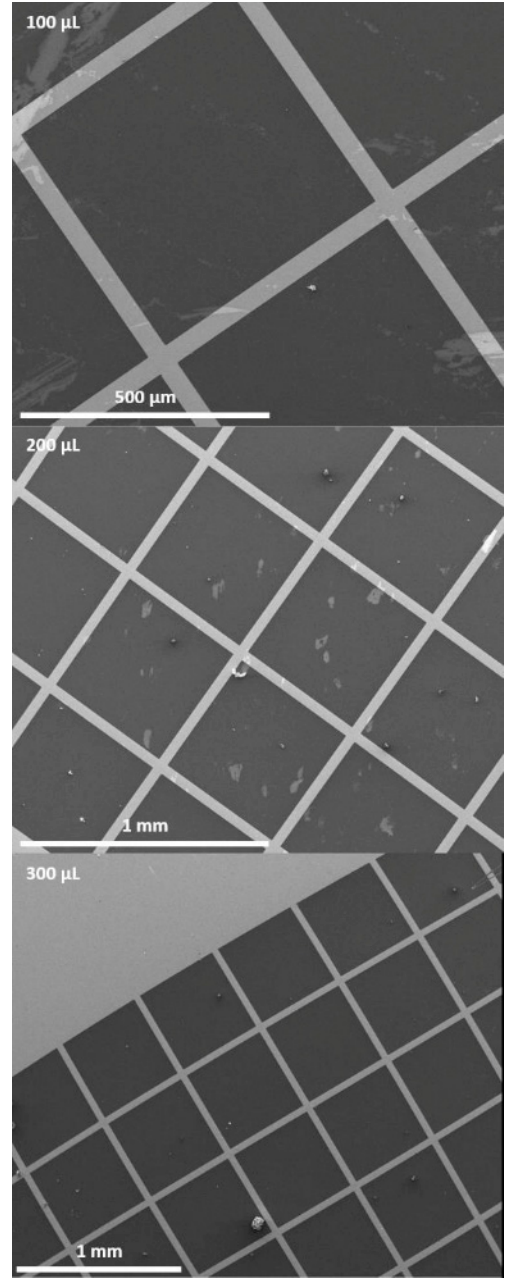
Figure 3. Larger area SEM images of DAD films spun from different solution volumes. A spin speed of 5000 rpm was used for all films.